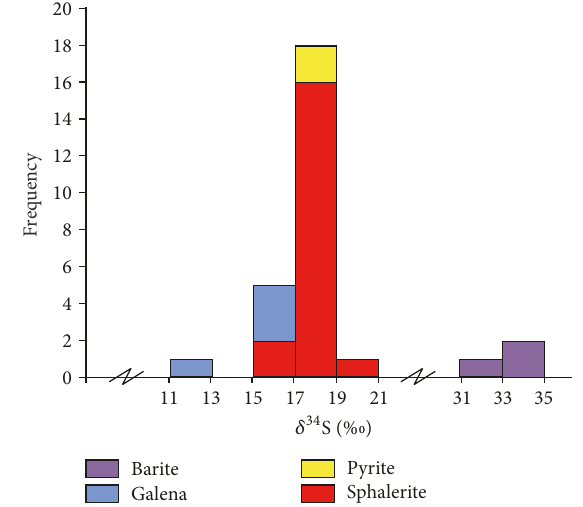
Figure 11: Histogram of sulfur isotopic compositions of sulfides and sulfate from the Mayuan district (data sources: Wang et al., 2008 [7]; Li et al., 2007 [9]; Hou et al., 2007 [17]; and this study). 𝛿 34 S value of +16.0‰[7] and galena in the Nananshan